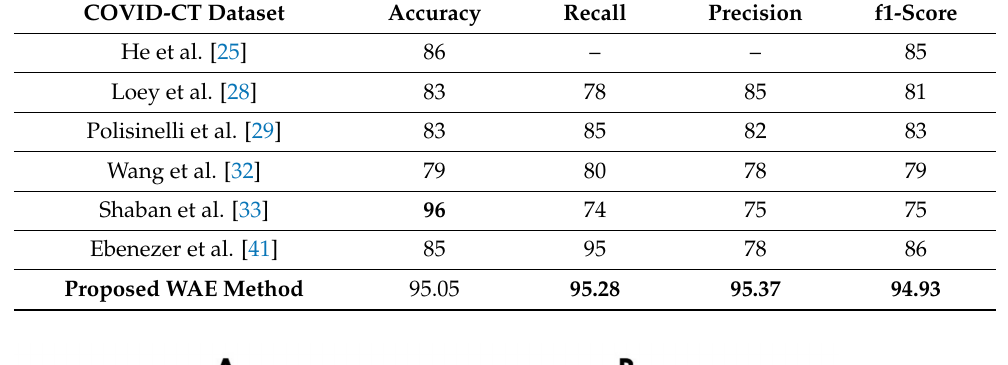
Table 10. Comparing the proposed WAE method with methods proposed in previous studies on the COVID-CT dataset [22].